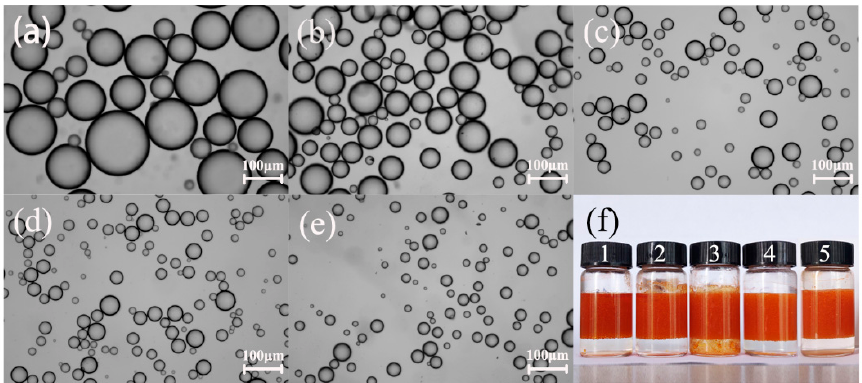
Figure 3. Microscopic images of a toluene (9 mL)-in-water (6 mL) Pickering emulsion prepared at different emulsification speeds ( a ) 4000 r/min, ( b ) 6000 r/min, ( c ) 8000 r/min, ( d ) 10,000 r/min, ( e ) 12,000 r/min with different droplet sizes 87.65 ± 35.52 μ m, 49.52 ± 17.88 μ m, 29.16 ± 10.93 μ m, 25.89 ± 8.57 μ m, 17.28 ± 7.75 μ m, respectively, and ( f ) visual photograph of the Pickering emulsion.